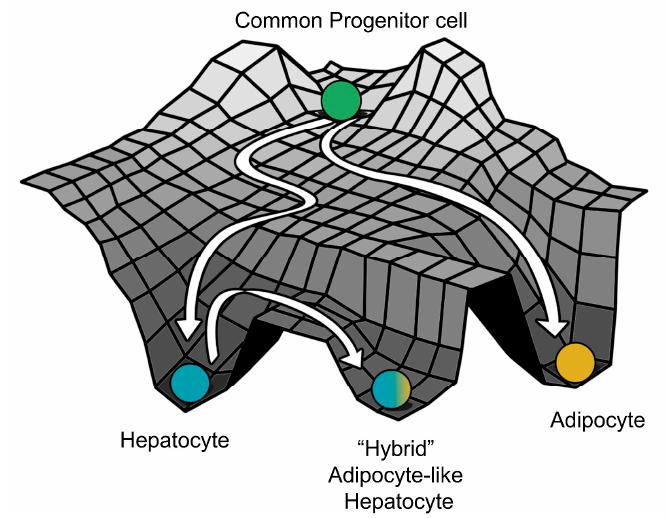
Figure 7. A schematic showing hepatocytes in a fatty liver as a distinct cell state due to “trans-differentiation” from the normal hepatocytes to a much more adipocyte-like “hybrid” cell state on the Waddington’s landscape (The Strategy of the Genes, Waddington C, 1957).